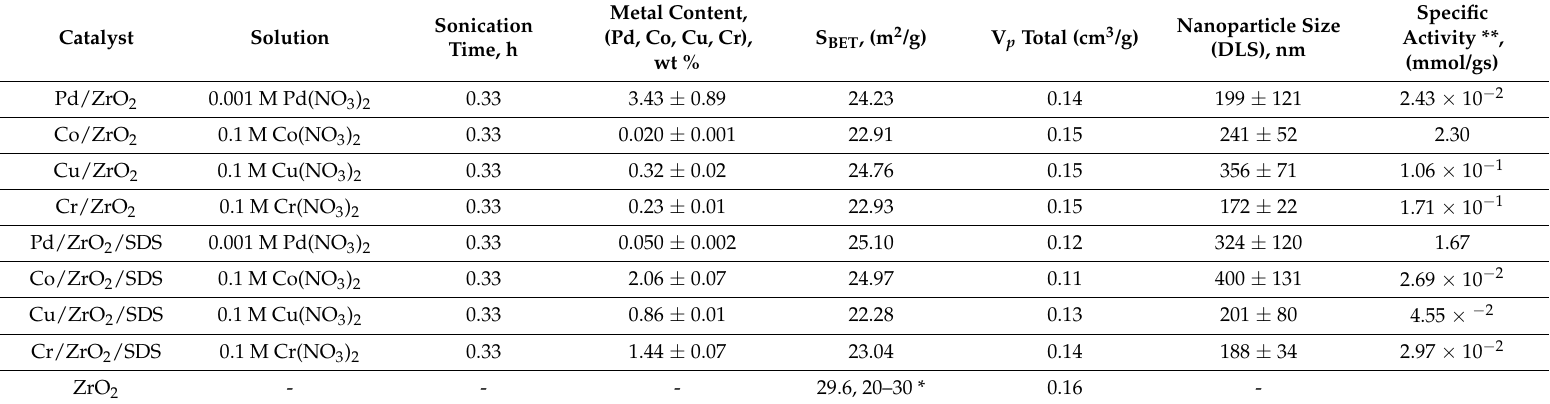
Table 1. Results of physicochemical characterisation of catalysts prepared via the sonochemical route. Abbreviation: DLS, dynamic light scattering.